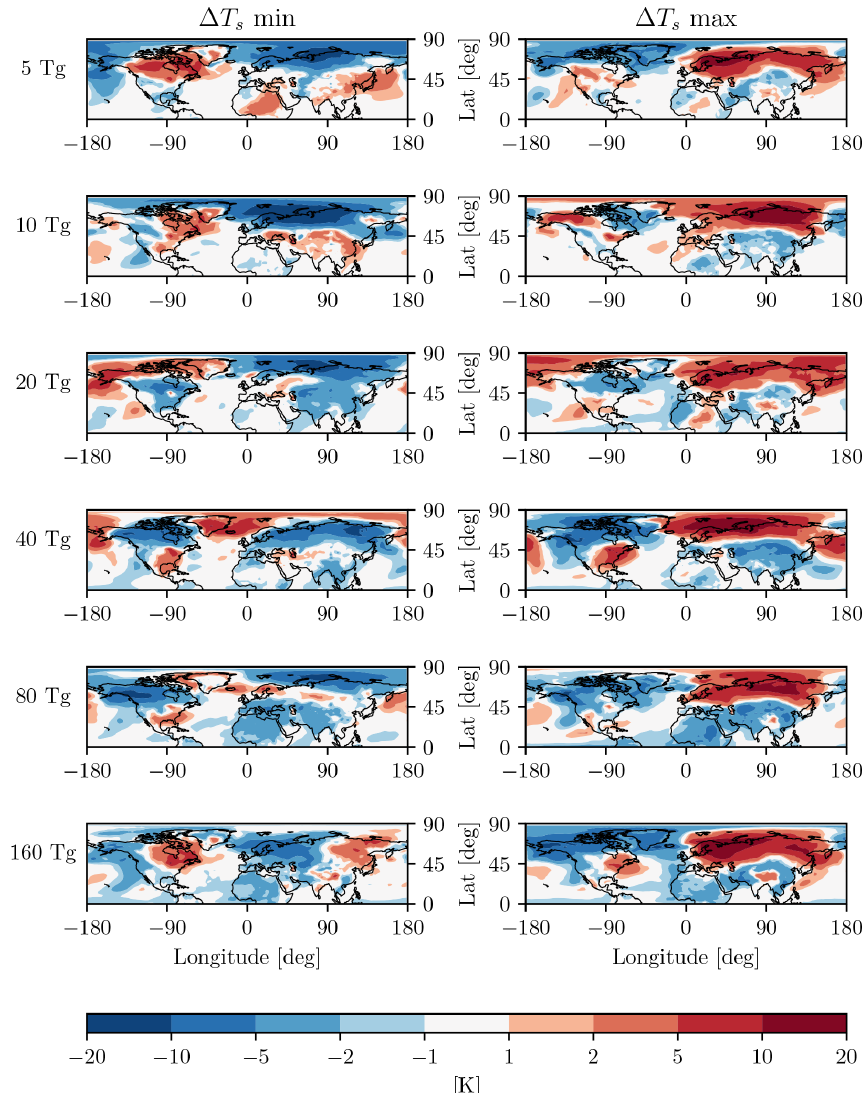
Figure 6. Coldest (left) and warmest (right) winter surface temperature anomalies over Eurasia in each 20-member ensemble, from 5 to 160Tg(S), top to bottom, as labeled. Note that the colorbar covers twice the range as the one in Fig. 5, as the variability is larger than the response, even for very large sulfur